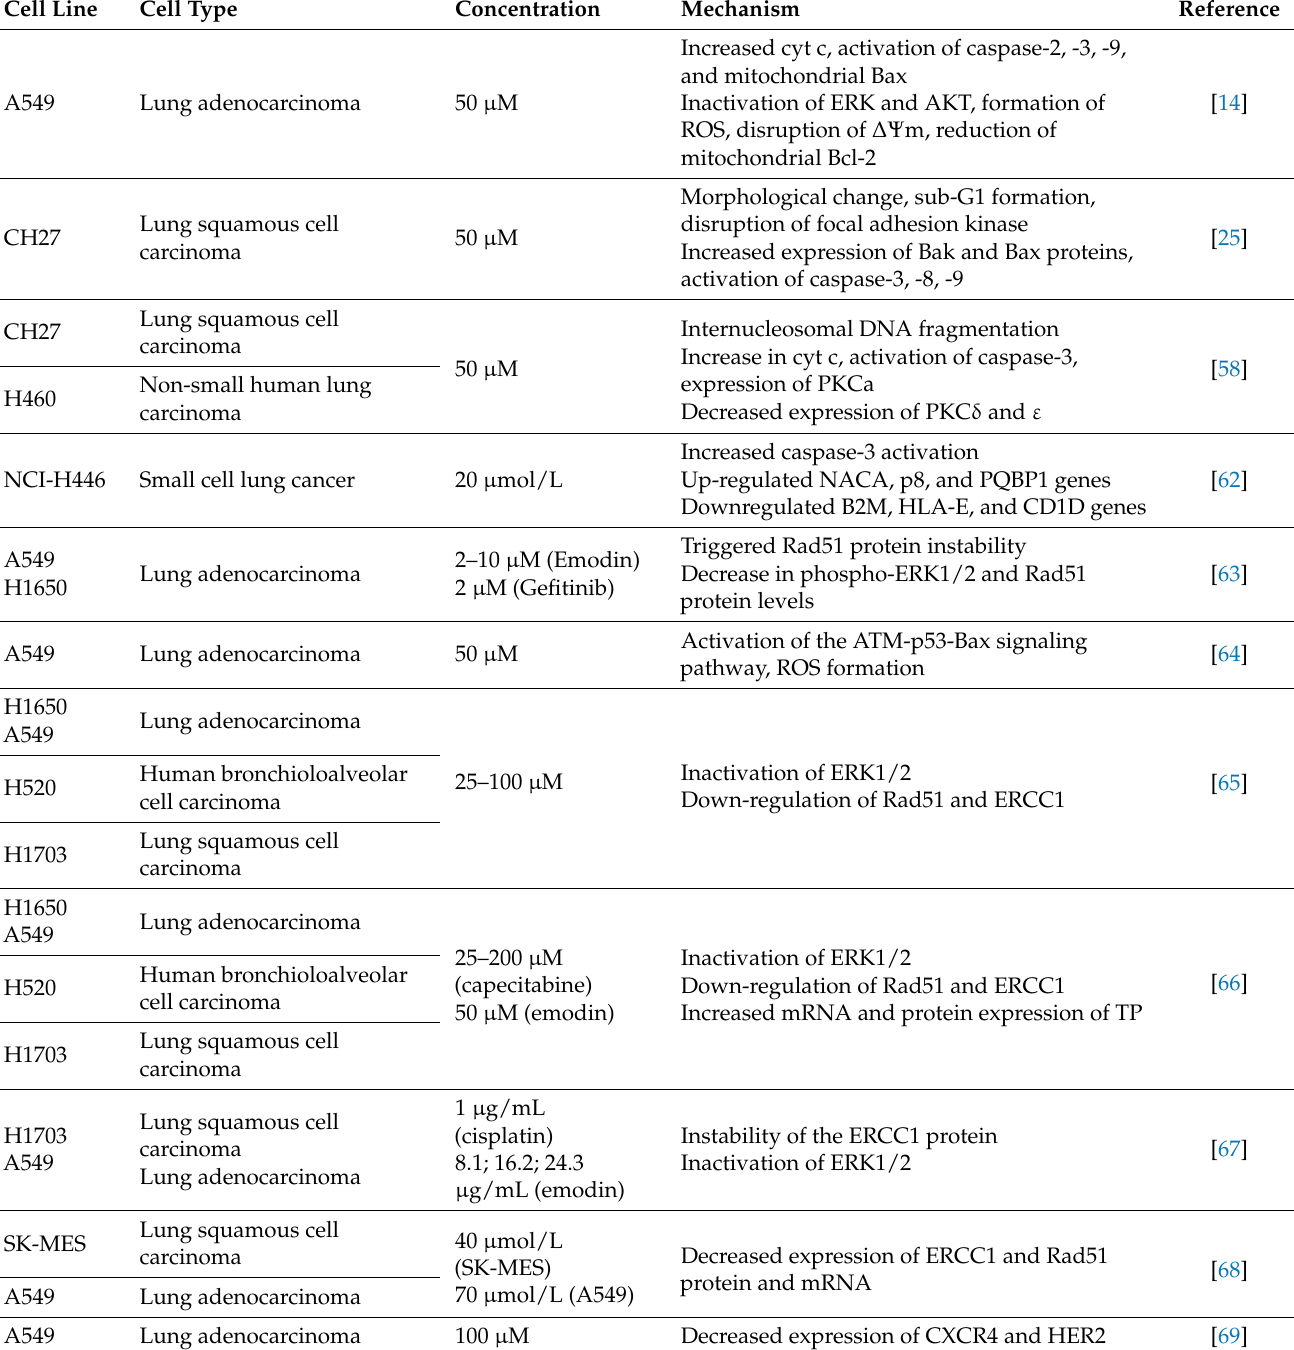
Table 1. Summary of biochemical effects of emodin in lung cancer cell